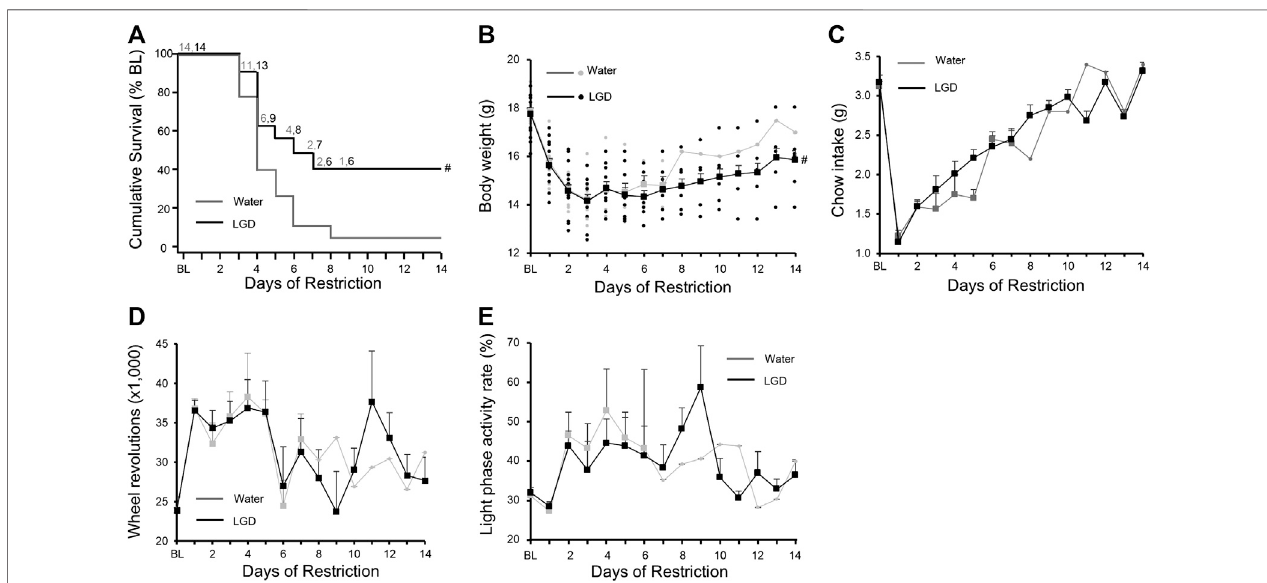
FIGURE 3 | Licorice and dried ginger decoction (LGD) improved survival rates in activity-based anorexia (ABA) mice (A) Comparison of the survival curves (B) Comparison of body weight reduction (C) Comparison of food intake reduction (D) Comparison of changes in wheel revolutions (E) Comparison of light phase activity rate. All results are expressed as mean ± SEM; statistical signi fi cance was recorded as # ( p < 0.05).